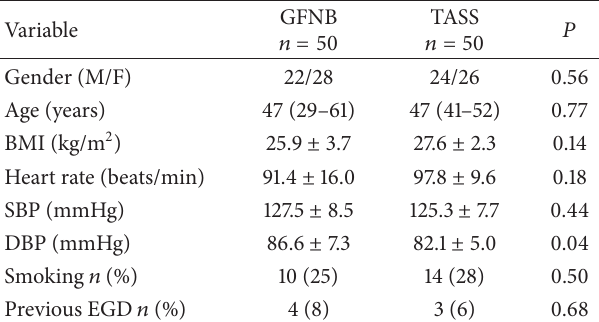
Table 1: Baseline characteristics of study groups.